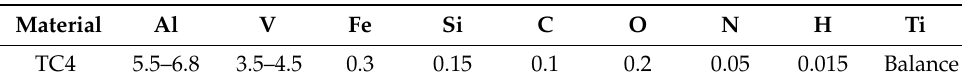
Table 1. The composition of